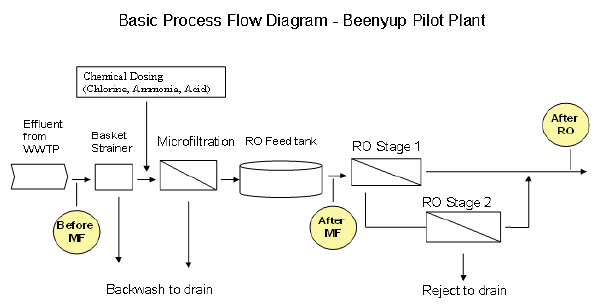
Figure 1: Schematic representation of the advanced treatment. Sample points represented by circles.